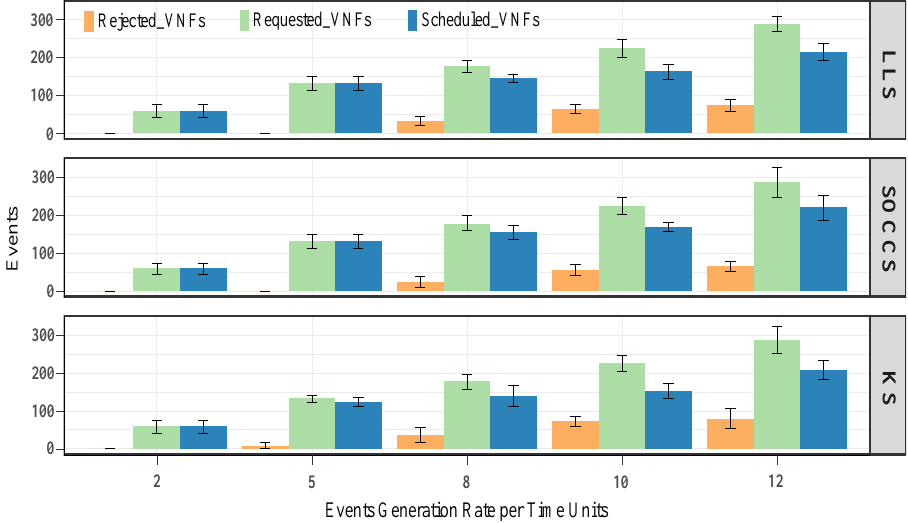
Figure 11. Number of requested, scheduled and rejected VNFs for all the scheduling